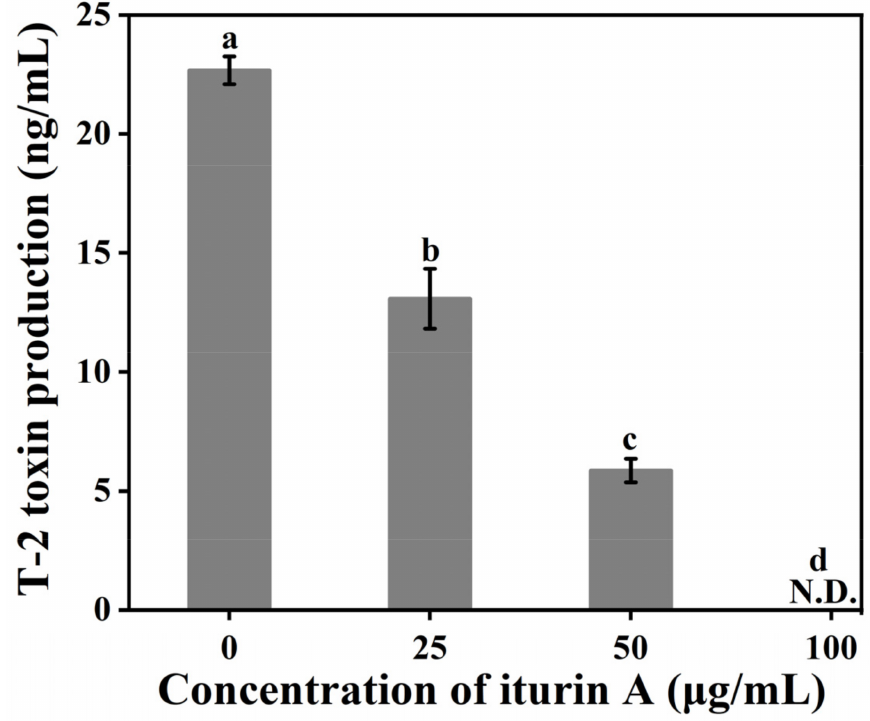
Figure 2. Effects of iturin A on T-2 toxin synthesis by F. oxysporum . (Different letters represent significant differences, p < 0.001; N.D.: Not